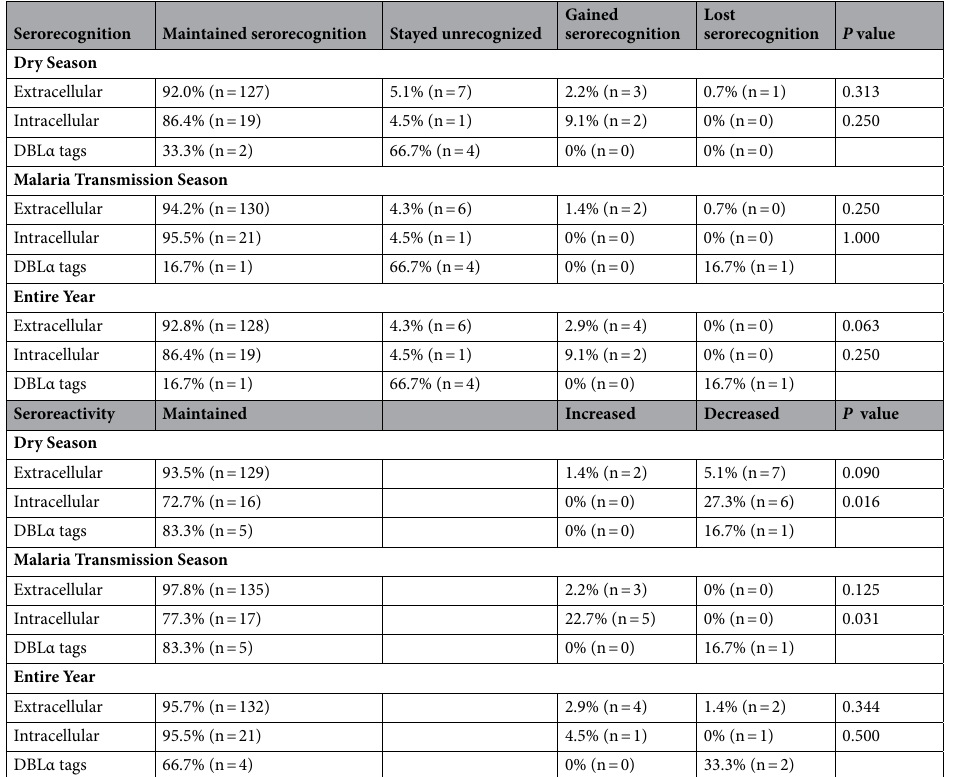
Table 1. Changes in serorecognition and seroreactivity for Malian adults as a group to 138 extracellular and 22 intracellular Plasmodium falciparum erythrocyte membrane protein-1 (PfEMP1) fragments across both seasons and the entire year. P values reflect whether changes across the given time interval are significant and are given by the binomial test; Wilcoxon matched-pairs signed-rank test determined serorecognition status across time periods for PfEMP1